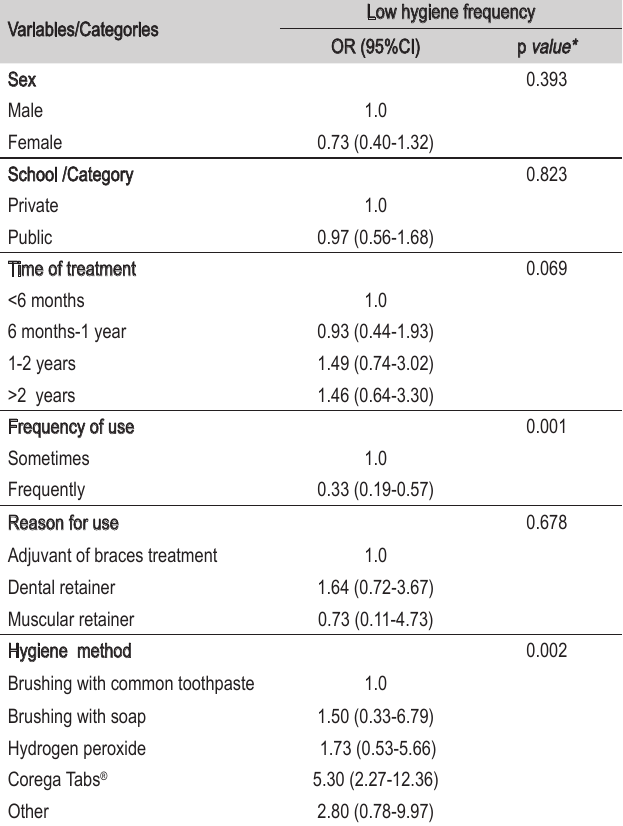
Table 4 - Odds ratio (OR) for hygiene frequency of removable orthodontic appliances wore by the students according to socio- demographic and behavioral factors. Pelotas, RS,